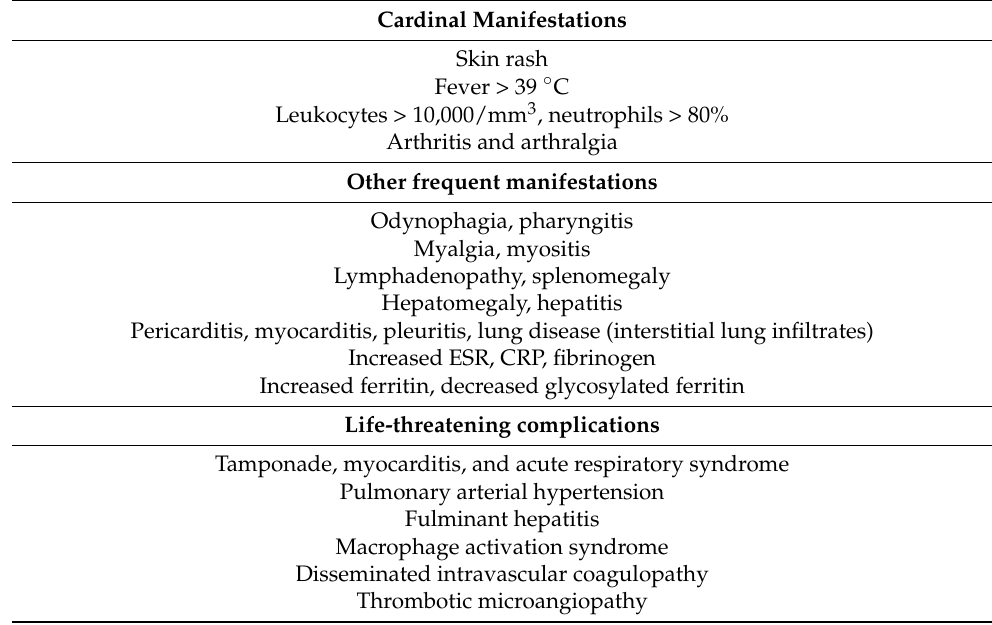
Table 1. Possible manifestations of